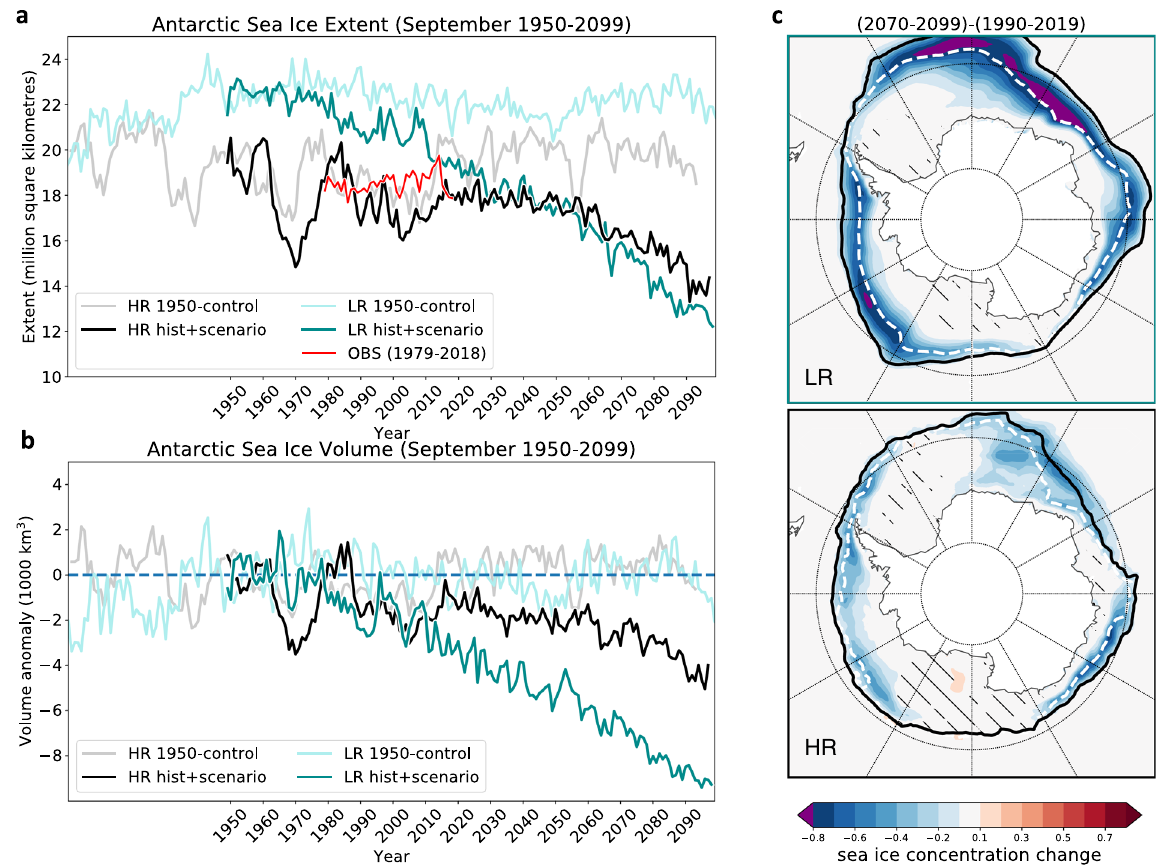
Fig. 3 Time series of observed historical September sea ice (1979 – 2018) and projections until the end of the twenty- fi rst century. a Historical and scenario simulations of September Antarctic sea-ice extent and b sea-ice volume anomaly in the high-resolution (HR; grey/black) and low-resolution (LR; light green/green) AWI-CM con fi gurations. Control simulations with atmospheric greenhouse gas concentrations fi xed at 1950 levels are shown in light colours; the red line depicts historical SIE observations (OBS) over the satellite era (see “ Methods ” ). The volume anomalies are relative to 1950-control means. c Patterns of projected sea-ice concentration changes in September (2070 – 2099 minus 1990 – 2019) in LR and HR. Black (white dashed) contours show the sea-ice extent for 1990 – 2019 (2070 – 2099). The “ delta approach" (see “ Methods ” ) has been applied in ( c ) to isolate the climate change signal. The signals are signi fi cantly larger than typical unforced 30yr-variability in the 1950 control simulations (see “ Methods ” ). Hatching indicates non- signi fi cant regions where the concentration changes are smaller than two standard